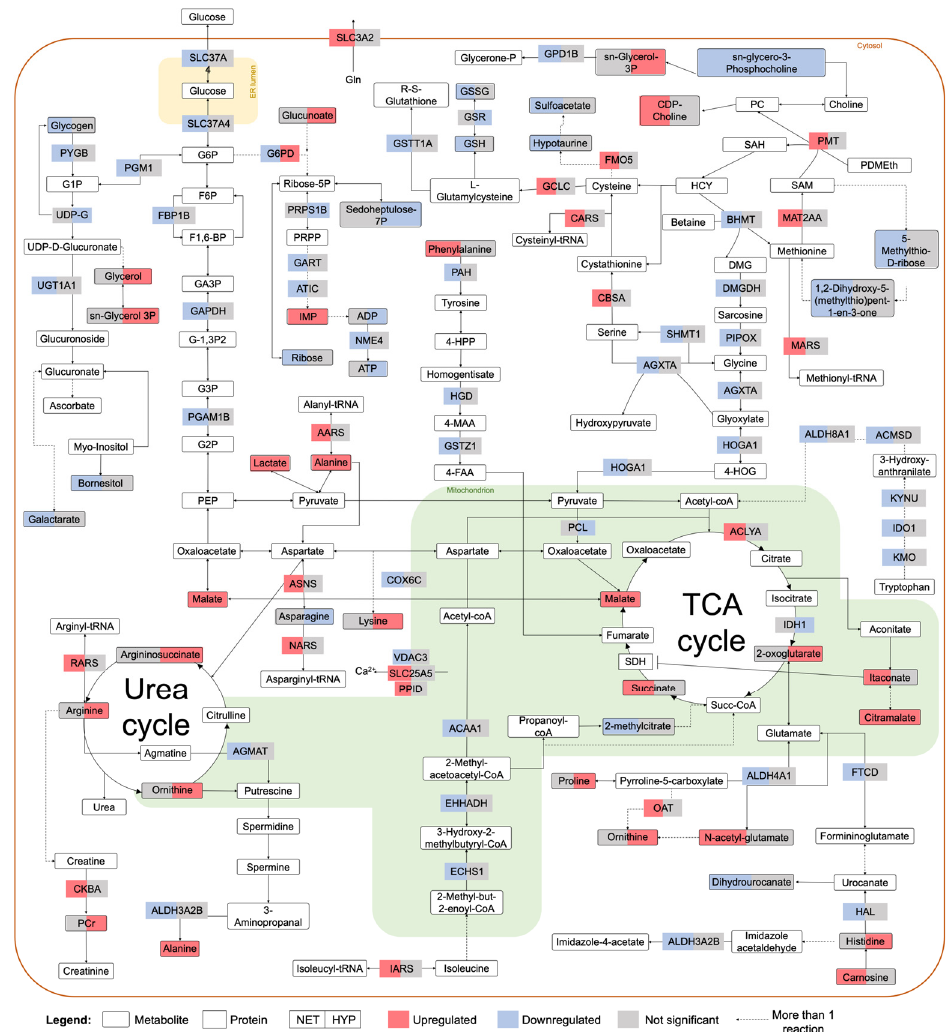
Figure 6. Overview of the metabolic pathways affected by net handling and hypoxia in gilthead seabream hepatocytes. The proteins and metabolites represented were significantly different in abundance, according to a Student’s t -test with FDR controlled at 0.05.